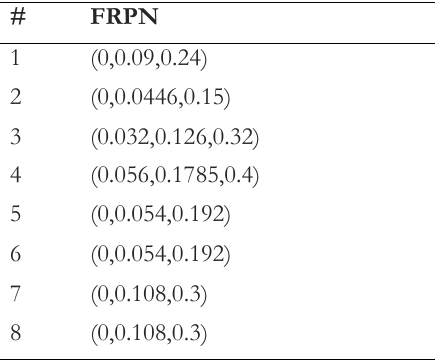
Table 4. Formation of membership function by multiplying the membership functions of severity, probability and